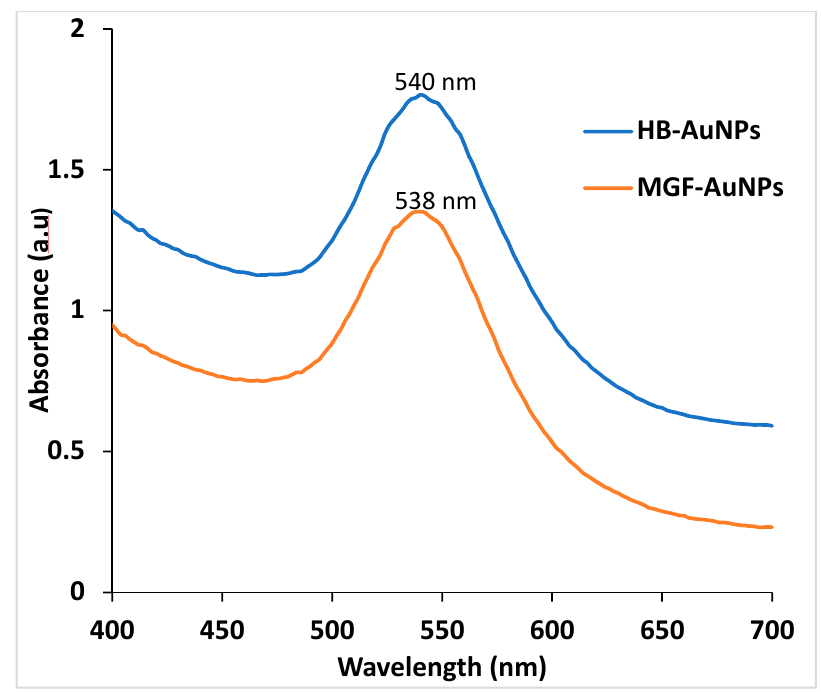
Figure 1. UV-Visible absorption of HB-AuNPs and MGF-AuNPs . The hydrodynamic diameter, polydispersity index (PDI) and zeta potential of the bi- ogenic AuNPs were measured by DLS. As shown in Table 2, the z-average sizes of HB- were 66.74 ± 9.7 nm and 65.50 ± 15.15 nm, respectively. The zeta potential and PDI of HB- AuNPs were − 23.45 ± 1.4 mV and 0.57 ± 0.01, respectively. MGF-AuNPs had a zeta poten- tial of − 27.87 ± 2.54 mV and a PDI of 0.43 ± 0.07. The characteristics of HB-AuNPs and MGF-AuNPs as measured by DLS were very similar. Nanoparticles with a zeta potential between − 30 and +30 mV are stable and will not aggregate in solution [36]. This suggests that HB-AuNPs and MGF-AuNPs are stable in solution. Table 2. Dynamic light scattering (DLS) analysis of HB-AuNPs and MGF-AuNPs. AuNPs